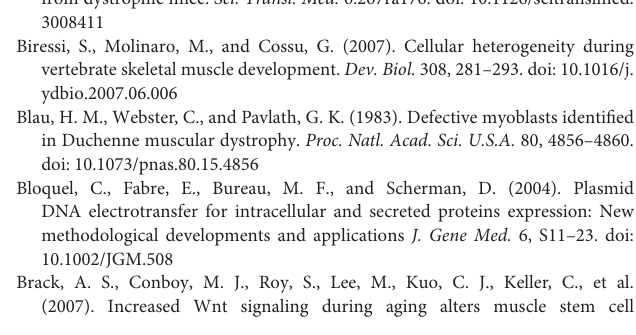
Supplementary Figure 1 | Gating strategy used to isolate single cell populations. (A) Representative gating and sorting strategy used to FACS isolate CD45 + ve , CD31 + ve , FAPs (CD45 − ve CD31 − ve sca1 + ve ) and MuSCs (CD45 − ve CD31 − ve sca1 − ve vcam + ve ) population from C57BL/6J and mdx 4Cv hindlimb muscles. Supplementary Figure 2 | In vivo electroporation of whole muscles and single cells. (A) Reflectance images of untreated gastrocnemius (CNTR − ve ) and electroporated TA (ET) shown in Figure 1A . Scale bar: 2.5 mm. (B) Representative Bruker In Vivo Xtreme I images (left) and GFP intensity measurement (photons/sec/mm 2 ) (right) of TA muscles from ∼ 14 months-old C57BL/6J mice injected with GFP plasmid and electroporated (ET) or not treated (CNTR − ve ). Scale bar: 2.5 mm. White color in the figure indicates photons/sec/mm 2 > 3.7e + 008. The analysis was performed 1.5 day after electroporation. (C–G) Representative FACS plot (left) and quantification (right) of electroporated (ET, GFP + ve ) single cells (C) , CD45 + ve cells (D) , CD31 + ve cells (E) , FAPs (F) and MuSCs (G) from TA of ∼ 14 months-old C57BL/6J mice injected with PBS (CNTR − ve ) or with GFP-expressing plasmid (ET) and electroporated. The analysis was performed 1.5 day after electroporation. N = 3 (ET), N = 1 (CNTR − ve ). FAPs: CD45 − ve CD31 − ve sca1 + ve cells; MuSCs: CD45 − ve CD31 − ve sca1 − ve vcam + ve cells. (H) Representative Bruker In Vivo Xtreme I images (left) and GFP intensity measurement (photons/sec/mm 2 ) (right) of TA muscles from ∼ 13 to 14 months-old C57BL/6J mice injected with β -gal (CNTR − ve ) or GFP plasmid (ET) and electroporated. Scale bar: 2.5 mm. White color in the figure indicates photons/sec/mm 2 > 1.5e + 008. The analysis was repeated 1, 2, 4, and 6 weeks (w) after electroporation. N = 4 (CNTR − ve 1w, ET 4w), N = 5 (ET 1w), N = 1 (CNTR − ve 2w, ET 2w, ET 6w). Supplementary Figure 3 | Histological analysis of electroporated muscles. (A) Immunofluorescence images of TA from additional ∼ 8 months-old C57BL/6J mice injected with GFP plasmid, electroporated and processed as described in Figure 1B . Muscles were stained with anti-GFP (green), anti-F4/80 (orange) antibodies, and Hoechst (blue). BF: Bright Field. Scale bar: 10 µ m. Note the presence of both electroporated (GFP + ve ) F4/80 + ve cells (red asterisks) and F4/80 − ve mononucleated muscle cells (red arrows). White asterisks and arrows are, respectively, marking examples of non-electroporated (GFP − ve ) F4/80 + ve and F4/80 − ve mononucleated muscle cells. (B–D) CNTR − ve FACS plot referred to Figures 1I–K showing CD45 + ve CD31 + ve cells (I) , FAPs (J) , and MuSCs (K) of TA of ∼ 4 months-old C57BL/6J mice injected with PBS and electroporated. Supplementary Figure 4 | Hyluronidase treatement in dystrophic muscles. (A) Representative Bruker In Vivo Xtreme I images (left) and GFP intensity measurement (photons/sec/mm 2 ) (right) of dissected TA from ∼ 6 months-old mdx 4Cv (MDX) mice injected with hyaluronidase (HYA) or not injected (NOT HYA). 2 h after hyaluronidase injection TA muscles were injected with PBS (CNTR − ve ) or GFP plasmid (ET) and electroporated. Scale bar: 2.5 mm. White color in the figure (left, top panel) indicates photons/sec/mm 2 > 1.6e + 010. Corresponding reflectance images are shown in the bottom panel. Muscles were analyzed 1 week after electroporation. N = 3. (B–E) CNTR − ve FACS plots referred to Figures 4H–K showing CD45 + ve cells (B) , CD31 + ve cells (C) , FAPs (D) ,